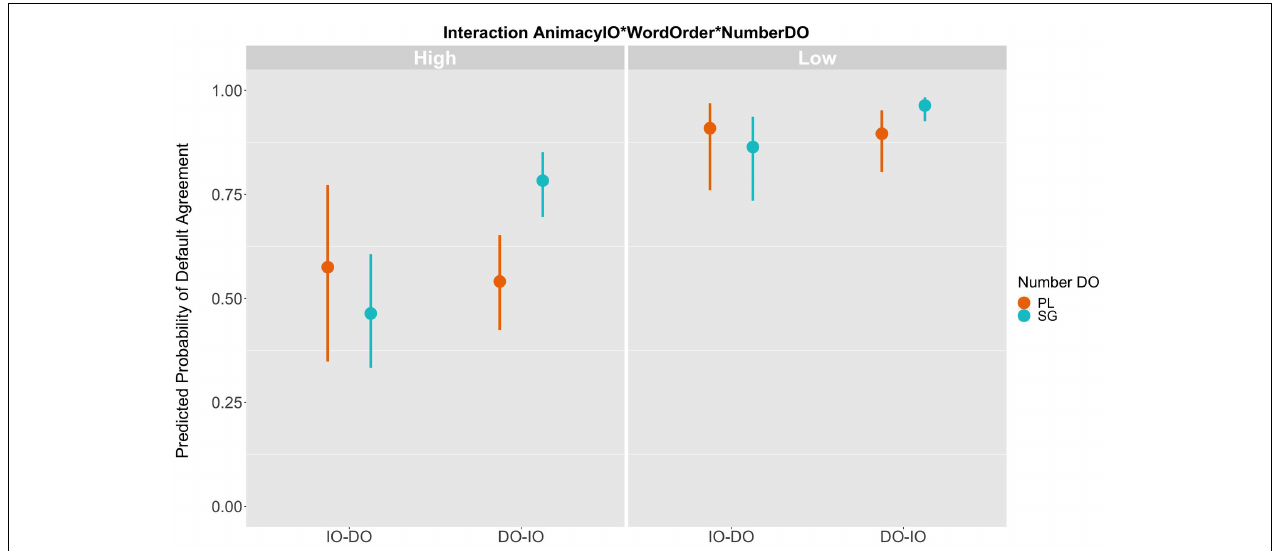
FIGURE 8 | Marginal effects of the three-way interaction AnimacyIO*WordOrder*NumberDO. The y-axis represents the predicted probability of default agreement per the mixed-effects